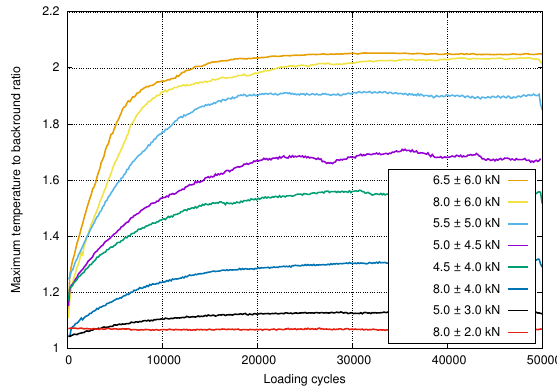
Figure 6. Ratio of specimen to ambient temperature as a function of number of cycles.